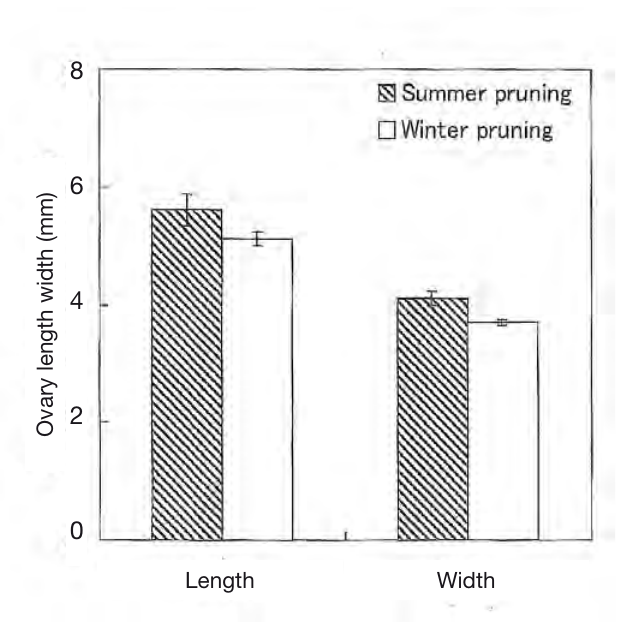
Fig. 4 - Effect of summer and winter pruning on ovary size of peach flowers on 4 April. Data are presented as mean ± standard er - ror ( se ).